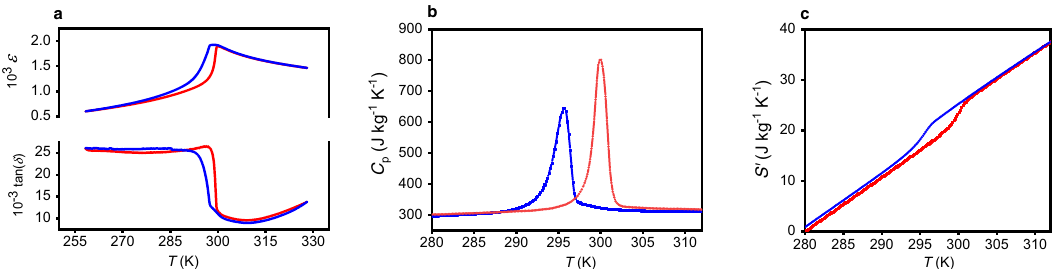
Fig. 1 Zero- fi eld measurements of PST. Blue and red curves denote respectively cooling and heating in the three plots. a The top plot shows the relative permittivity ε and the lower plot the loss tangent tan( δ ), both as a function of temperature T . b Zero- fi eld speci fi c heat C p (background value) measurements associated with latent heat Q 0 (integral under the fi rst-order phase transition peak at T 0 = 300 K on heating and 296 K on cooling). c S ′ ( T ) = S ( T ) − S (280 K) represents the entropy S ( T ) referenced to the entropy at 280 K far from T 0 with S ′ (280 K) =